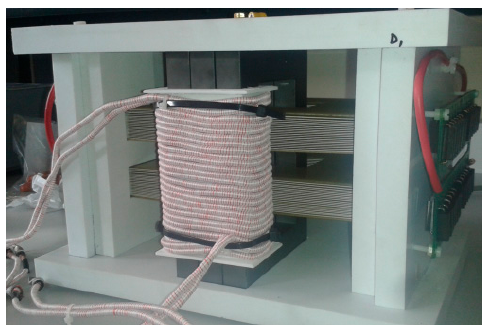
Figure 12. High-voltage transformer.